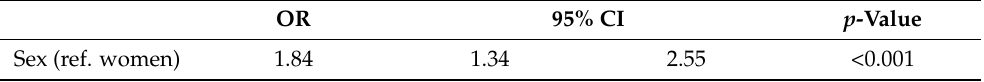
Table 3. Univariate logistic regression analysis with sex (POD vs. non-POD group). OR 95% CI p